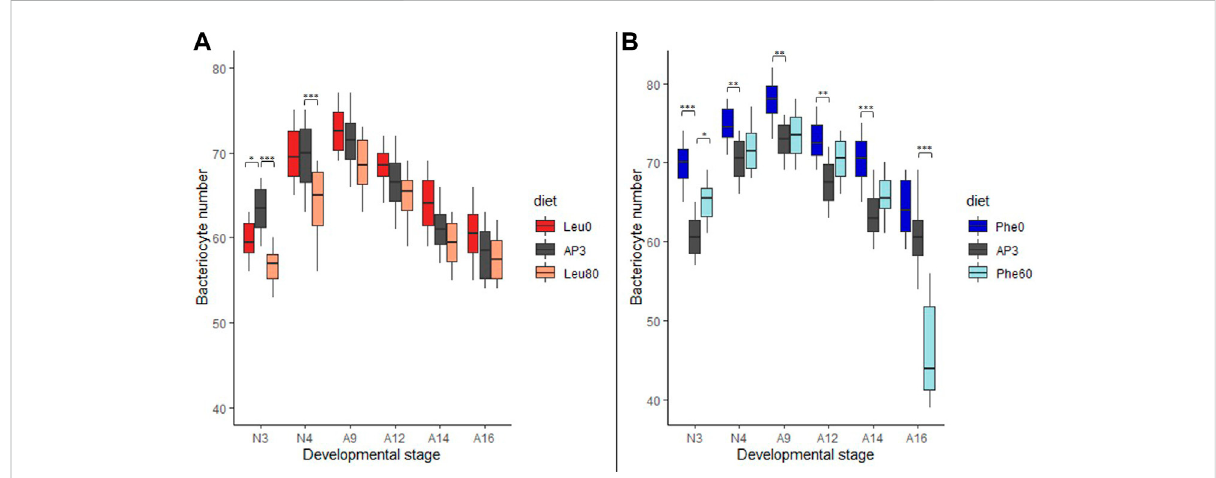
FIGURE 2 Impactofleucineand phenylalanine depletionorexcess onbacteriocytenumber. (A) Variation inthenumberofbacteriocytesperaphid reared onAP3(darkgray),Leu0(red)orLeu80(orange)diets,inrelationtohostdevelopmentalstages. (B) Variationinthenumberofbacteriocytesperaphid reared on AP3 (dark gray), Phe0 (dark blue) or Phe60 (light blue) diets, in relation to host developmental stages. Results are displayed as box plots where central lines represent the medians, boxes comprise the 25 – 75 percentiles and whiskers denote the range; n = 10 aphids per stage and per condition, for a total number of 180 aphids dissected and analyzed. Data were analyzed with a factorial linear model followed by a post hoc multiple comparisons test (Tukey ’ s HSD test). Signi fi cant differences are indicated with asterisks (*, p < 0.05; **, p < 0.01). Abbreviations: N1 to N4, nymphal stages from 1 to 4; A9-A16, adult time points from day 9 to day